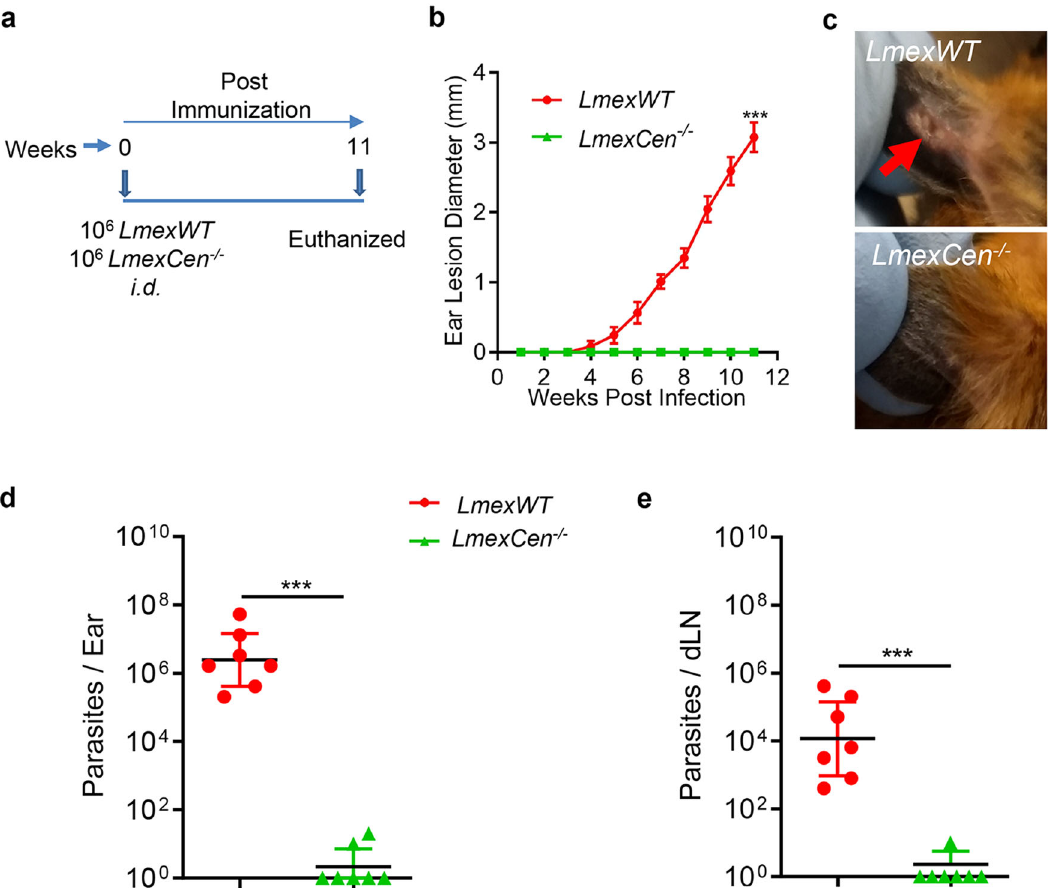
Fig. 1 Live attenuated LmexCen − / − parasites are safe and do not cause lesions in hamster. a Schematic representation of the experimental plan. b Lesion size was monitored every week in hamsters injected with 10 6 -total stationary phase either LmexWT or LmexCen − / − parasites by intradermal (i.d) injection. Ear lesion diameters were measured at indicated weeks post inoculation. Results (SEM) are representative cumulative effect of two independent experiments, 1 ear, total 7 hamsters per group (*** p = 0.0006 values were determined by Mann – Whitney two-tailed test). c Photographs of representative ears of LmexWT and LmexCen − / − immunized hamsters at 11 weeks post inoculation (PI). Red arrow indicates the lesion development. Parasites load in the ear ( d ) and draining lymph node (dLN) ( e ) of LmexWT and LmexCen − / − immunized hamsters were determined by serial dilution assay at 11 weeks post inoculation. Results (the geometric means with 95% Cl) represent cumulative of two independent experiments; in fi rst experiment n = 4/group and in second experiment n = 3/group (*** p = 0.0006 values were determined by Mann – Whitney two-tailed